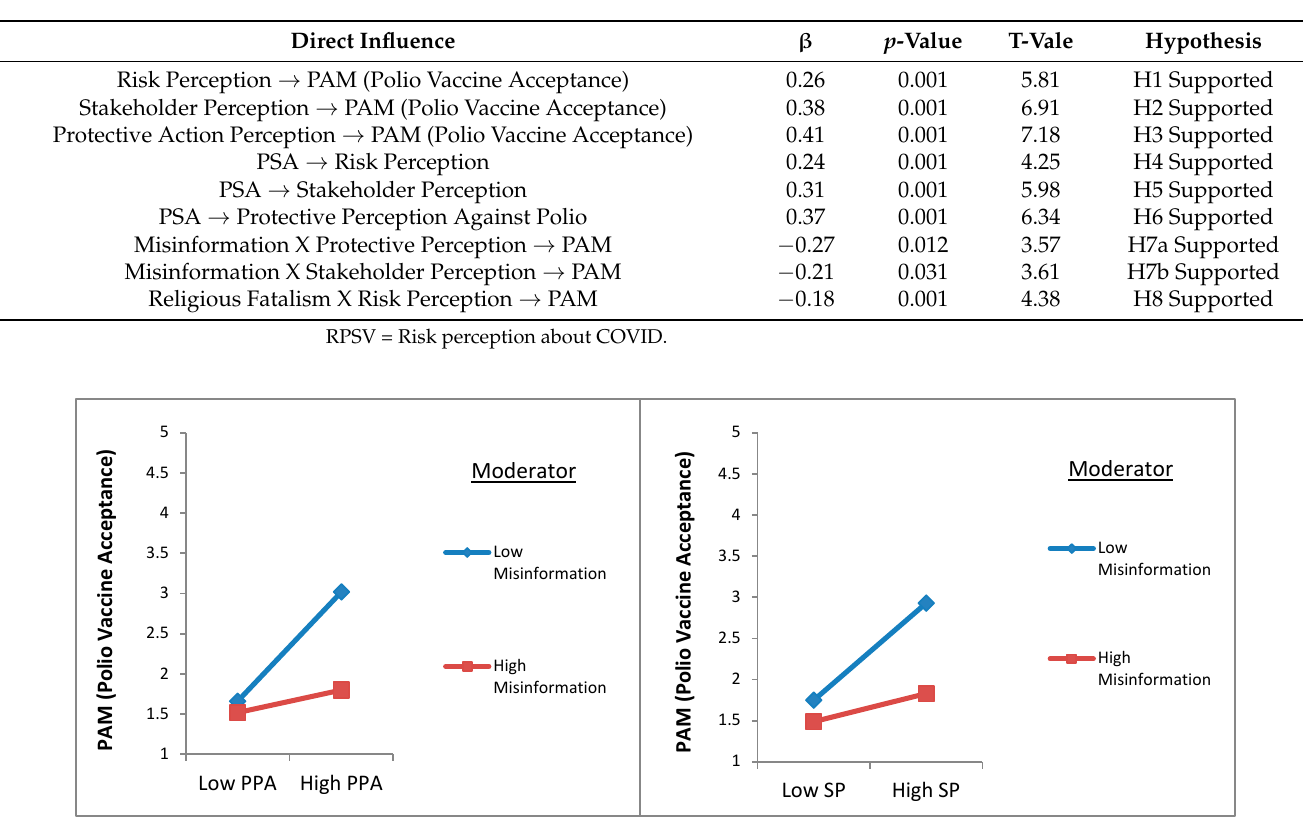
Figure 4. Moderation of misinformation.